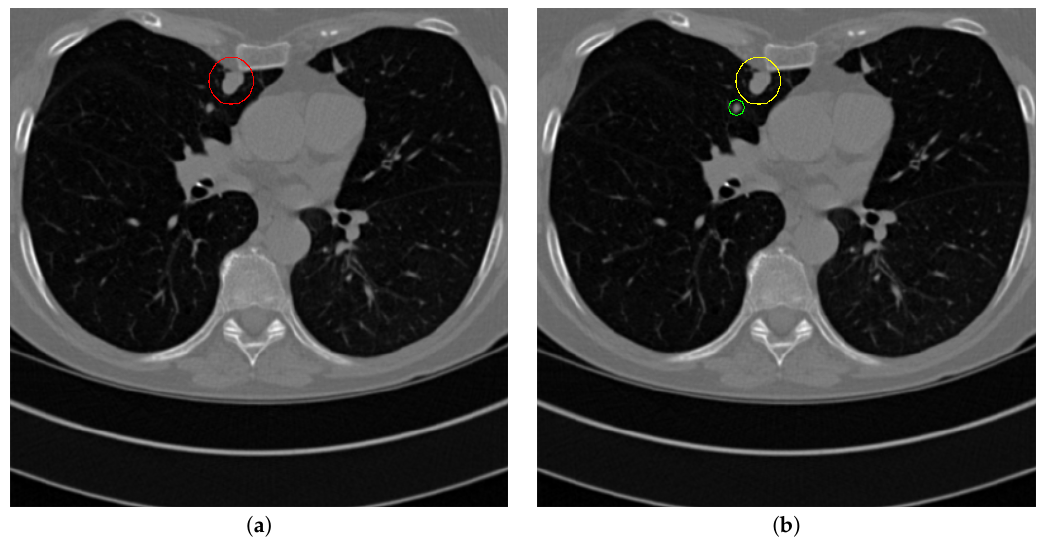
Figure 23. Failure detection case. ( a ) is the ground truth nodule detection result, ( b ) is the nodule detection by the proposed method. Red circle represents the ground truth region of nodule, green circle represents the over-detected nodule, while yellow circle denotes the nodule being